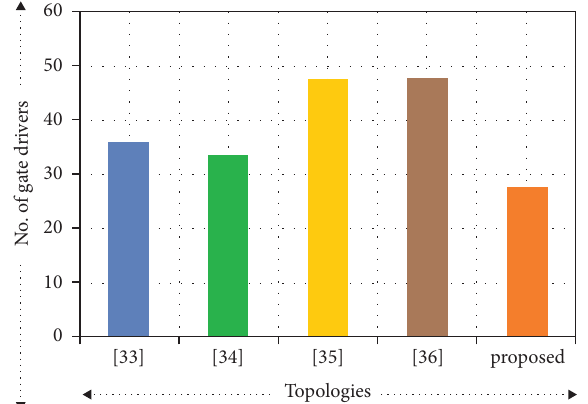
Figure 8: Comparison of number of gate drivers required in recent topologies vs. proposed topology.